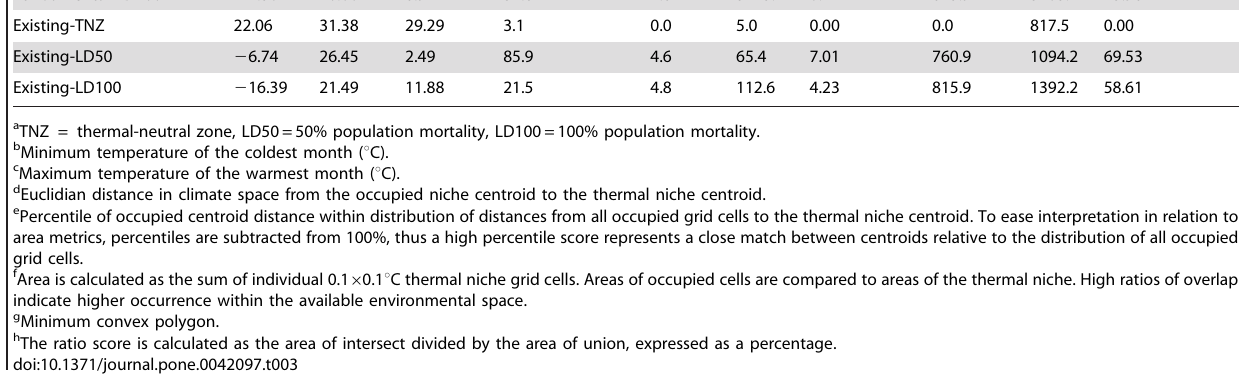
Thermal niche type & fitness threshold